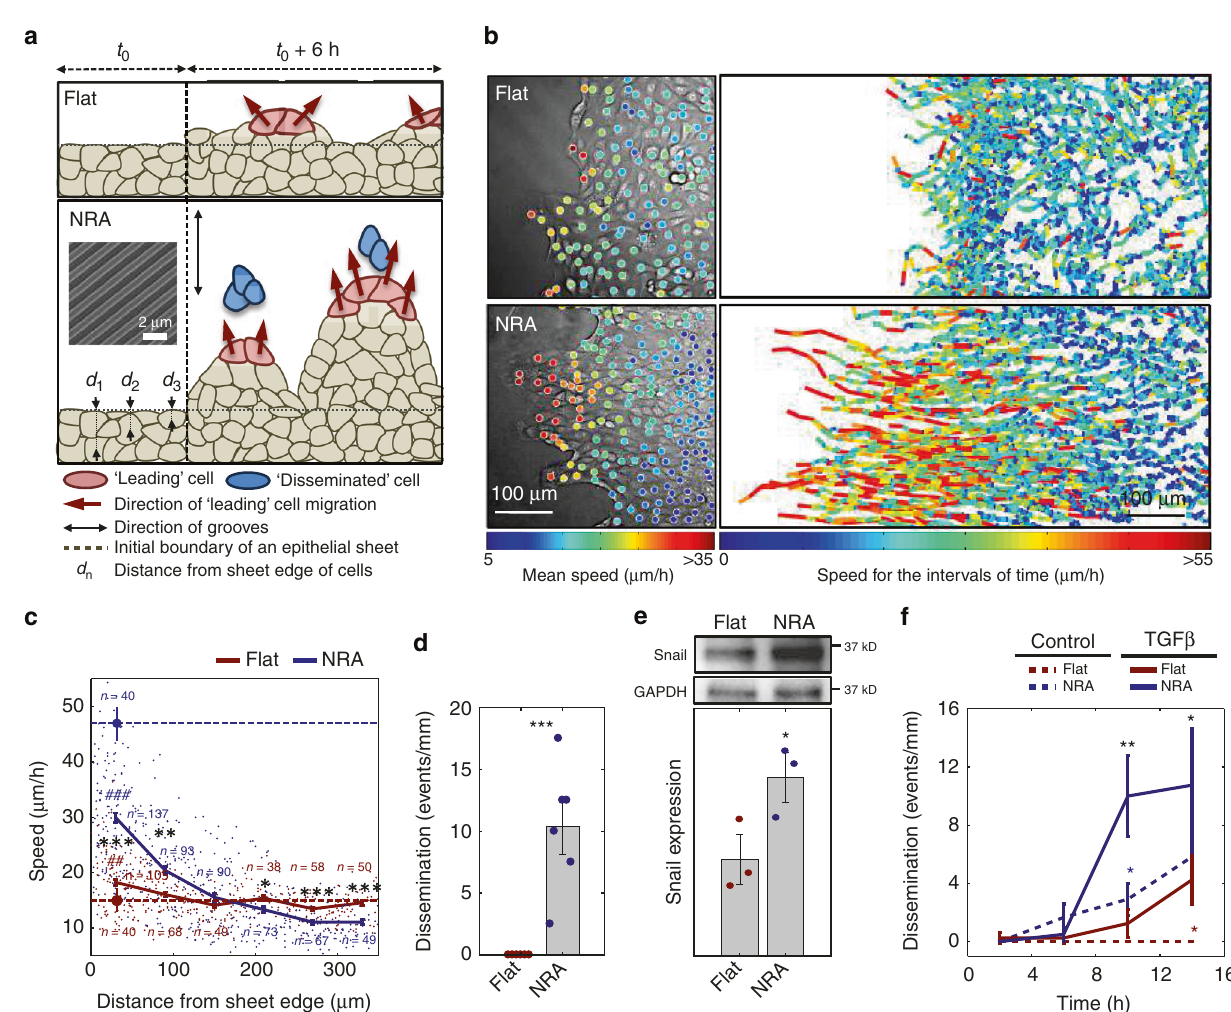
Fig. 1 Anisotropic texture of the mechanical environment increases EMT. a Schematic depiction of the edge areas of the expanding epithelial sheets, including formation of the fi nger-like protrusions (FLPs) led by “ leading ” cells and occasional separation of the tip cells ( “ dissemination ” ). It also de fi nes the distance metric for the cell migration analysis in this and subsequent fi gures. The inset shows the electron micrograph of the NRA. b Cell trajectories colored to re fl ect the cell speed values in an expanding sheet on fl at surfaces (top) and NRA (bottom). The colors of each dot indicate the mean speed values of the corresponding cells (left). The trajectories were tracked for 6 h with the speed measured every 20 min (right). c Migration speed of individual cells on fl at and NRA substrata at different initial distances from the edge of the sheet (corresponding to values of d in panel a ). Each dot represents the average speed of an individual cell. Dashed lines indicate the averaged speed of isolated individual cells on a fl at surface (red) and NRA (blue) (each number of independently analyzed cells, n , is indicated, # = statistical signi fi cance of speed on the marginal region vs. the most submarginal region of cells on a fl at surface (red) and NRA (blue), ## P < 5 × 10 − 4 and ### P < 5 × 10 − 6 , * = statistical signi fi cance of the speed of cells on a fl at surface vs. NRA, and * P < 0.05, ** P < 5 × 10 − 4 , and *** P < 5 × 10 − 6 ). d Disseminations from epithelial sheets per unit length of epithelial sheets on fl at substrata and NRA for 18 h ( n = 4 biologically independent experiments, * = statistical signi fi cance of numbers of dissemination on fl at surfaces vs. NRA. *** P < 5 × 10 − 6 ). e The expression of Snail in the cells on fl at surfaces and NRA analyzed by immunoblotting ( n = 3 biologically independent samples, * = statistical signi fi cance of Snail expression in cells on fl at vs. NRA substrata, * P < 0.05). f Dissemination from epithelial sheets on fl at substrata and NRA in the presence of TGF β ( n = 4 biologically independent samples, * = statistical signi fi cance of the number of disseminations with control vs. TGF β on the fl at substratum (red) and on NRA (blue), fl at substrata vs. NRA with TGF β (black), * P < 0.05 and ** P < 1 × 10 − 2 ). All error bars are S.E.M and statistical signi fi cance was